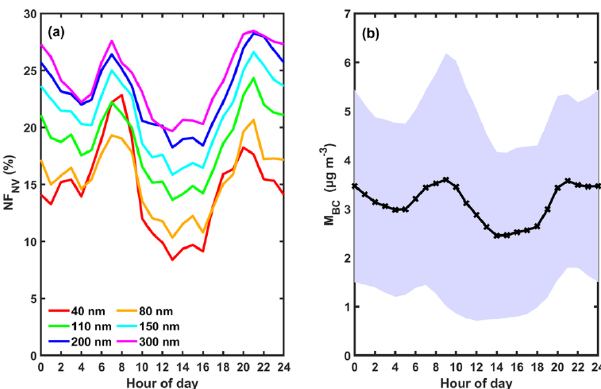
Figure 6. Diurnal variations in (a) size-resolved number fractions of nonvolatile particles (NF NV ) and (b) mass concentration of black carbon ( M BC ). The purple shaded area shows the standard devia- tions of M BC